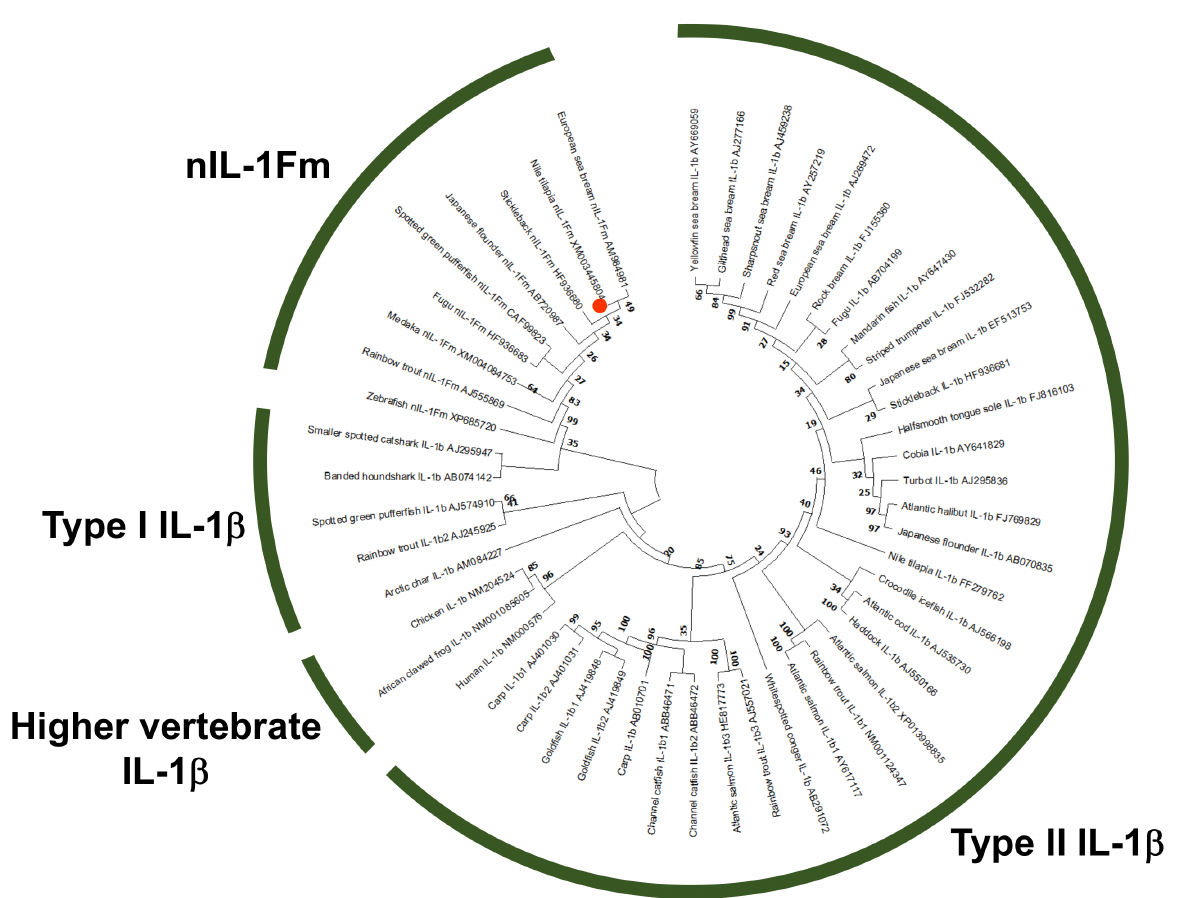
Figure 4. Phylogenetic tree of nIL-1F, type I, and type II IL-1 β and other known homologues derived from GenBank. The Nile tilapia nIL-1Fm was indicated by red